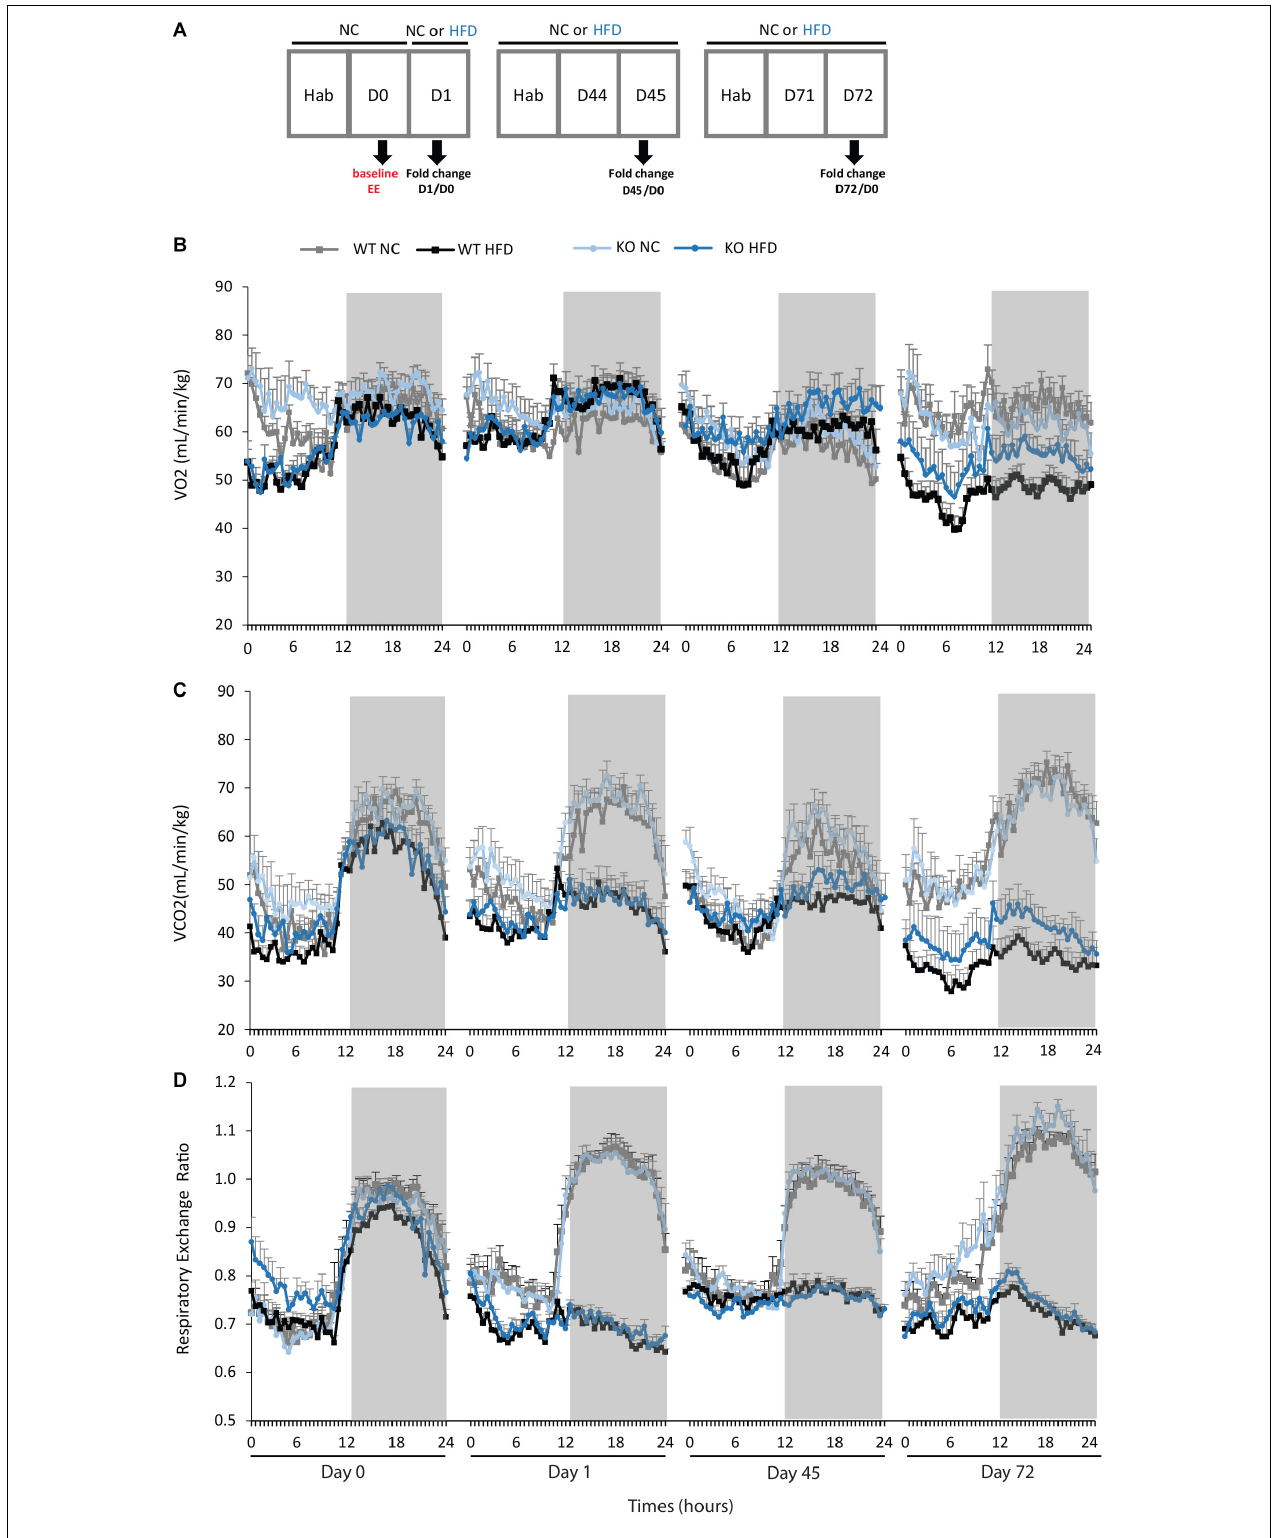
FIGURE 5 | Calorimetry measurements of VO 2 , VCO 2 , and RER during HFD feeding. (A) Time line illustrating the protocol used for calorimetry measurements. WT and KO mice fed with either normal chow (NC) or a high-fat diet (HFD) were subjected to indirect calorimetry to assess VO 2 ( B , mL/min/kg), VCO 2 ( C , mL/min/kg) and RER (D) . Data shown are mean ±